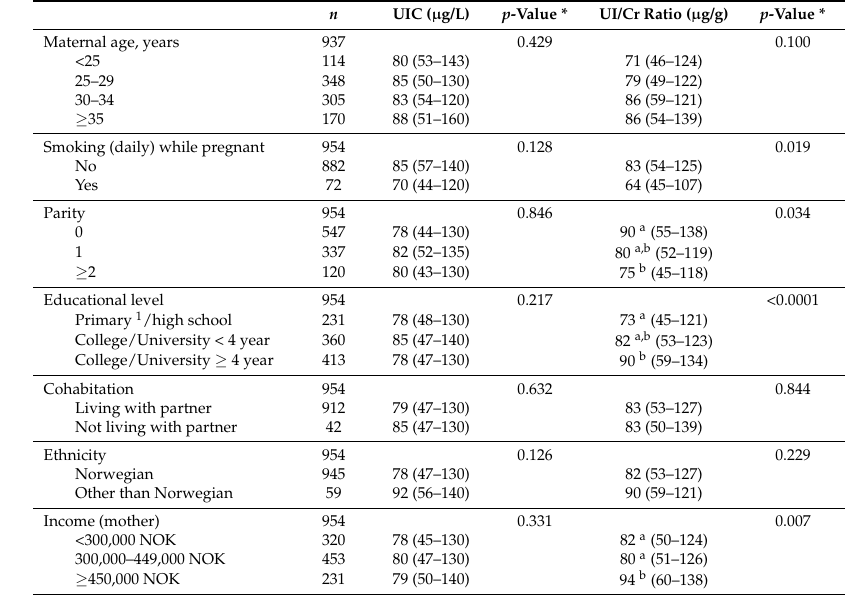
Table 1. Urinary iodine concentration ( µ g/L (UIC)) and urinary iodine to creatinine ratio ( µ g iodine/g creatinine (UI/Cr ratio)) according to maternal demographic and behavioral characteristics given as median with 25th and 75th percentiles in the study